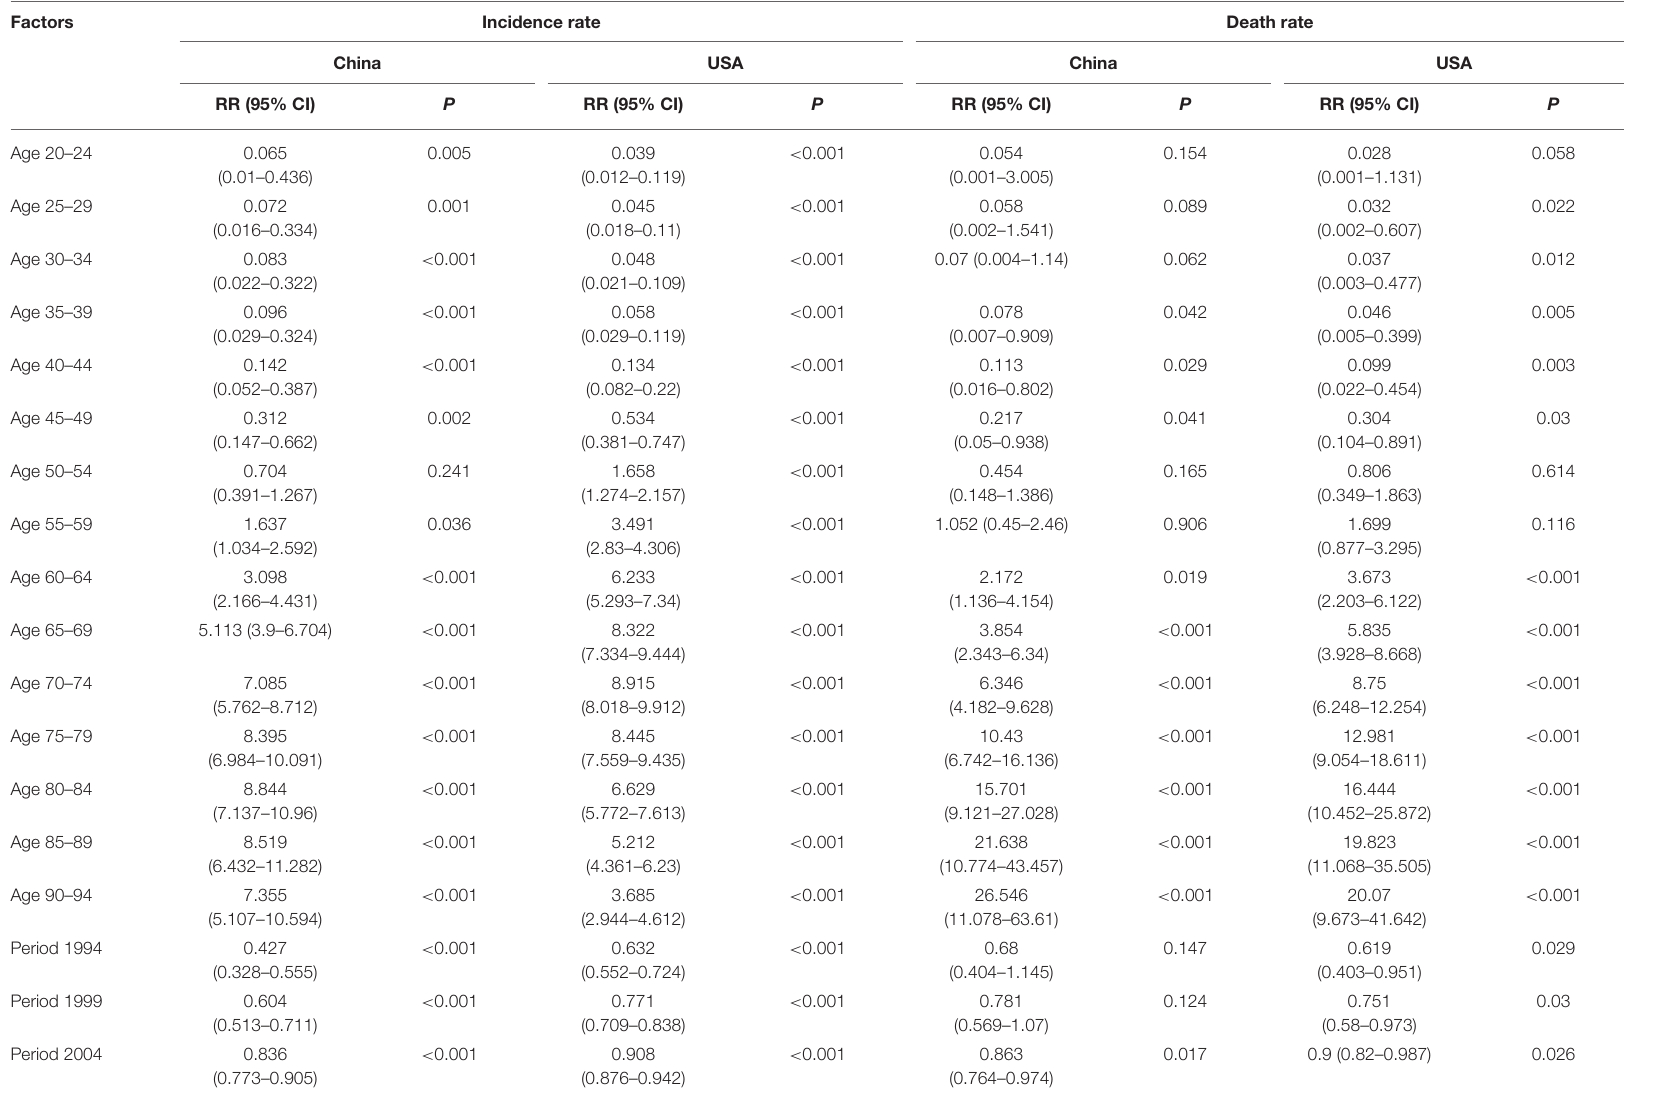
TABLE 1 | The age, period and cohort effects on incidence and death rate in China and